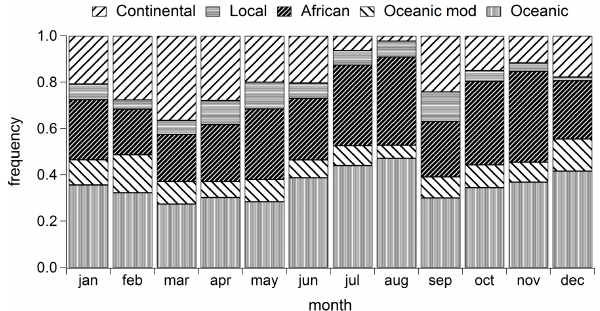
Figure 10. Variation of hygroscopic growth factor (GF), kappa value ( κ) and number fractions (NF) measured at RH90 as a func- tion of air mass origin for particles in the nucleation mode (top panel), Aitken mode (middle panel) and accumulation mode (bot- tom panel). The figure shows the median GF value, with the bottom and top sides of the box giving the 25th and 75th percentiles, and the extremities the 10th and 90th percentiles. The coloured bars il- lustrate the NF of particles found in each hygroscopic